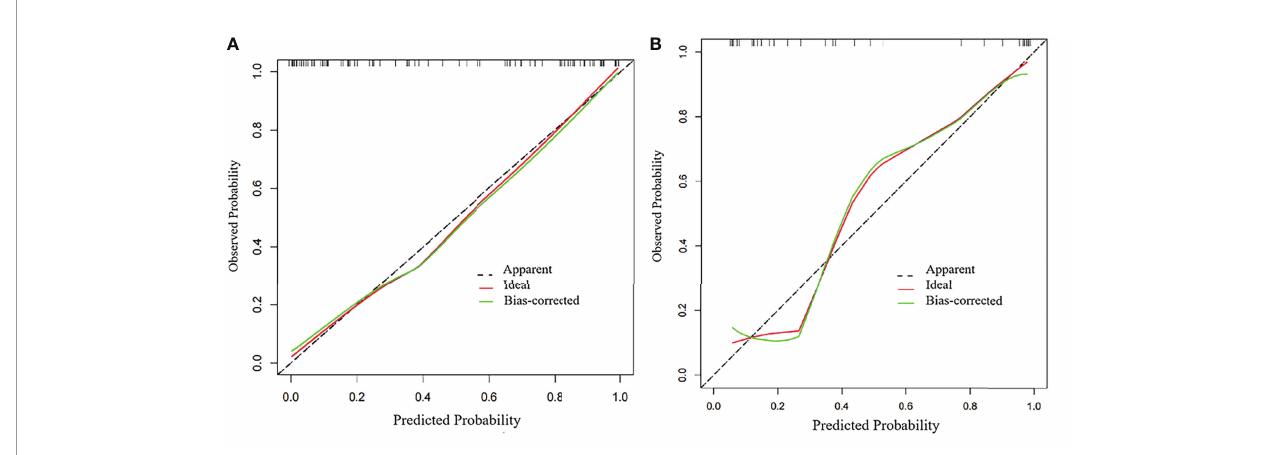
FIGURE 5 | Calibration curves of the radiomics nomogram in the (A) training group and (B) testing